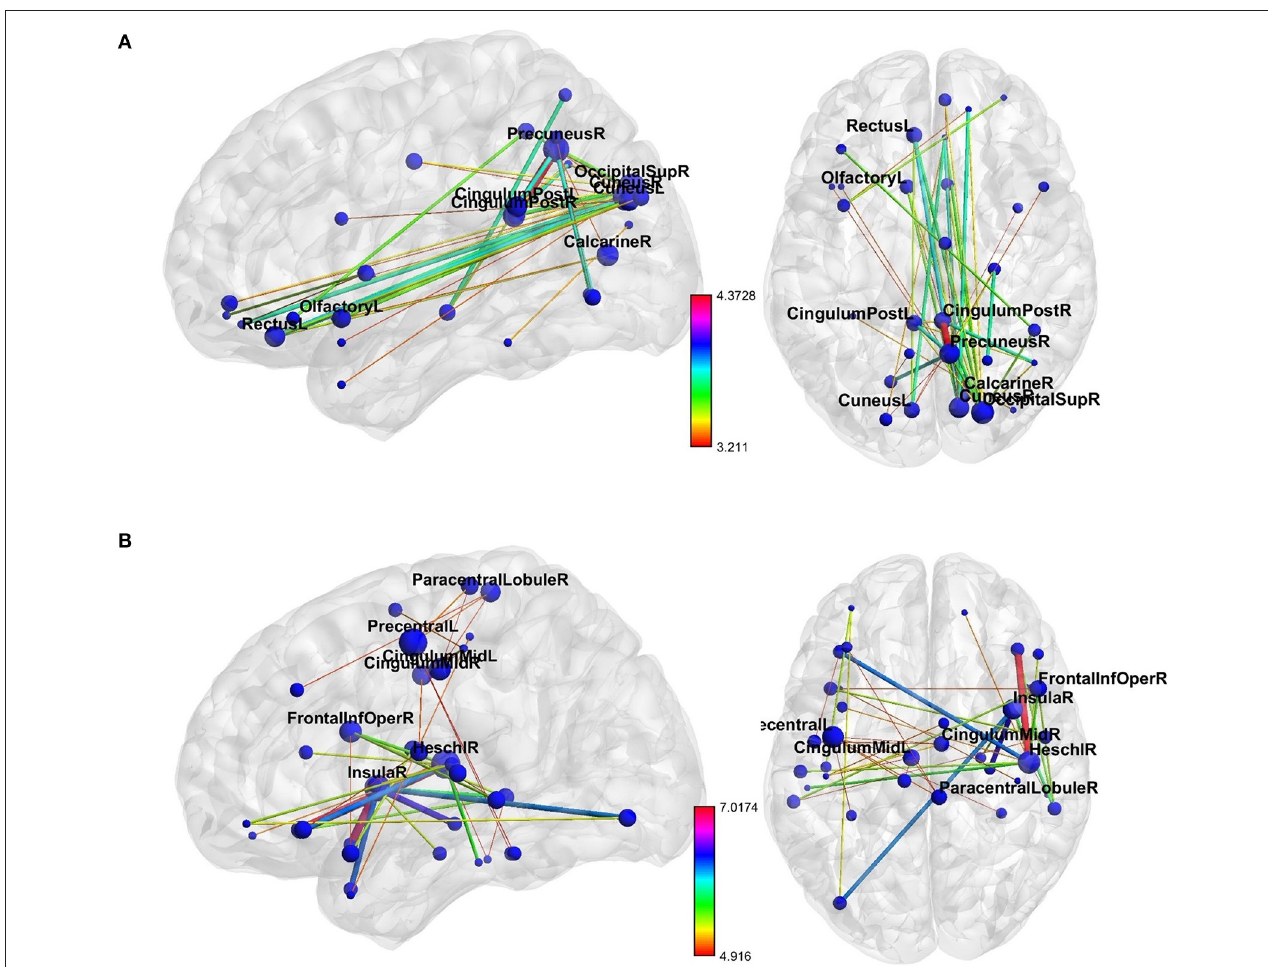
FIGURE 5 | The networks of increased resting-state (A) gamma- and (B) theta-band connectivity during the ketamine compared to placebo administration. The size of each node represents its number of connections within the network (degree). The thickness and color of connections represent the t -value. Labels are provided for nodes with at least three connections. As shown in Table 3 , these nodes are involved in more than 50% of total interactions within the theta-network and more than 70% of total interactions within the gamma-network. The figure was created using BrainNet Viewer